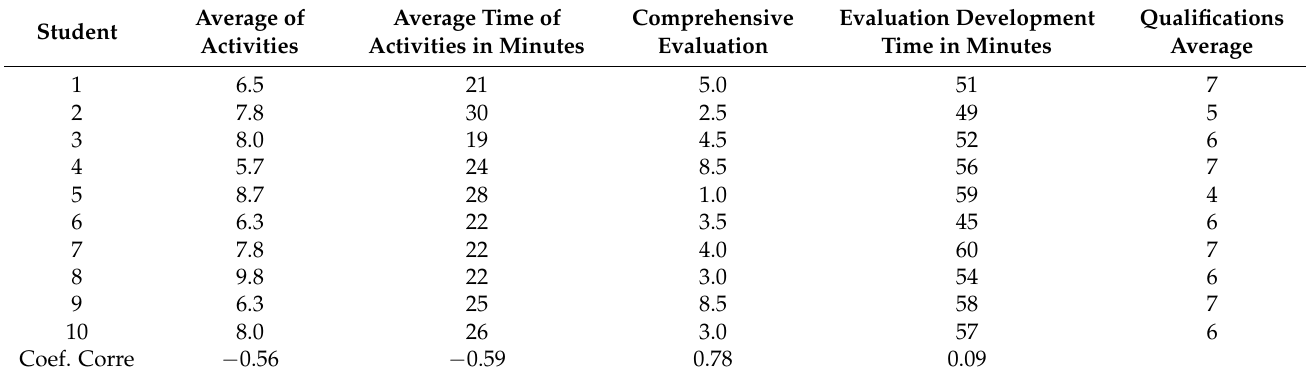
Table 4. Results of data processing, classification of activities, score of the comprehensive evaluation period versus development times